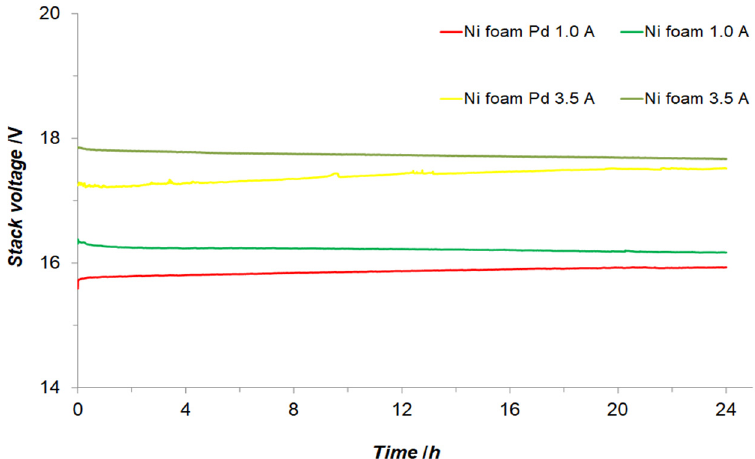
Figure 8. Electrolyser stack’s voltage in function of electrolysis time. The process was carried out at 45 °C in 8 M KOH solution for current intensities of 1.0 and 3.5 A (anode: Ni foam; cathode: Ni foam or Pd-modified Ni foam), and solution recirculation rate of 50 cm 3 min − 1 .